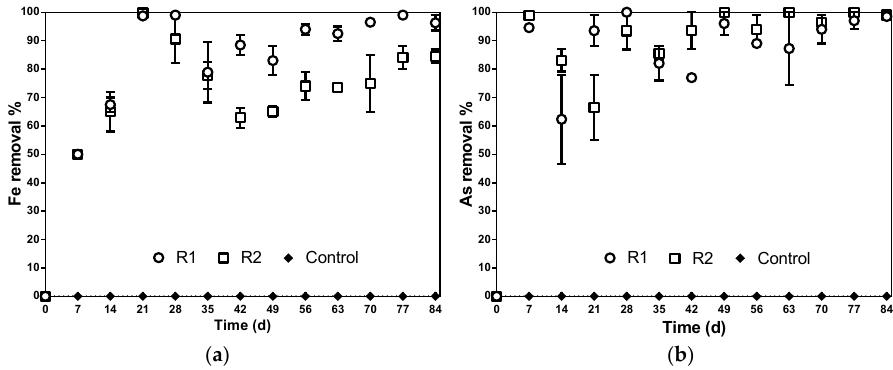
Figure 4. Total dissolved Fe ( a ) and As ( b ) removal during batch reactor operation. A marked removal of As and Fe was observed after 14 days of operation. The metal removal data are the mean of two reactors (average of two replicates) . Initial concentrations in batch reactors were As = 3.6 mg·L − 1 , Fe = 81 mg·L − 1 and SO 42 − = 4678 mg·L − 1 . The data are presented as the mean ± SEM (error bars). X-ray diffraction that was performed on the precipitated solids (lyophilized) recovered at the end of batch sulfate reduction experiments shows a strongly bulging amorphous baseline (Figure 5).